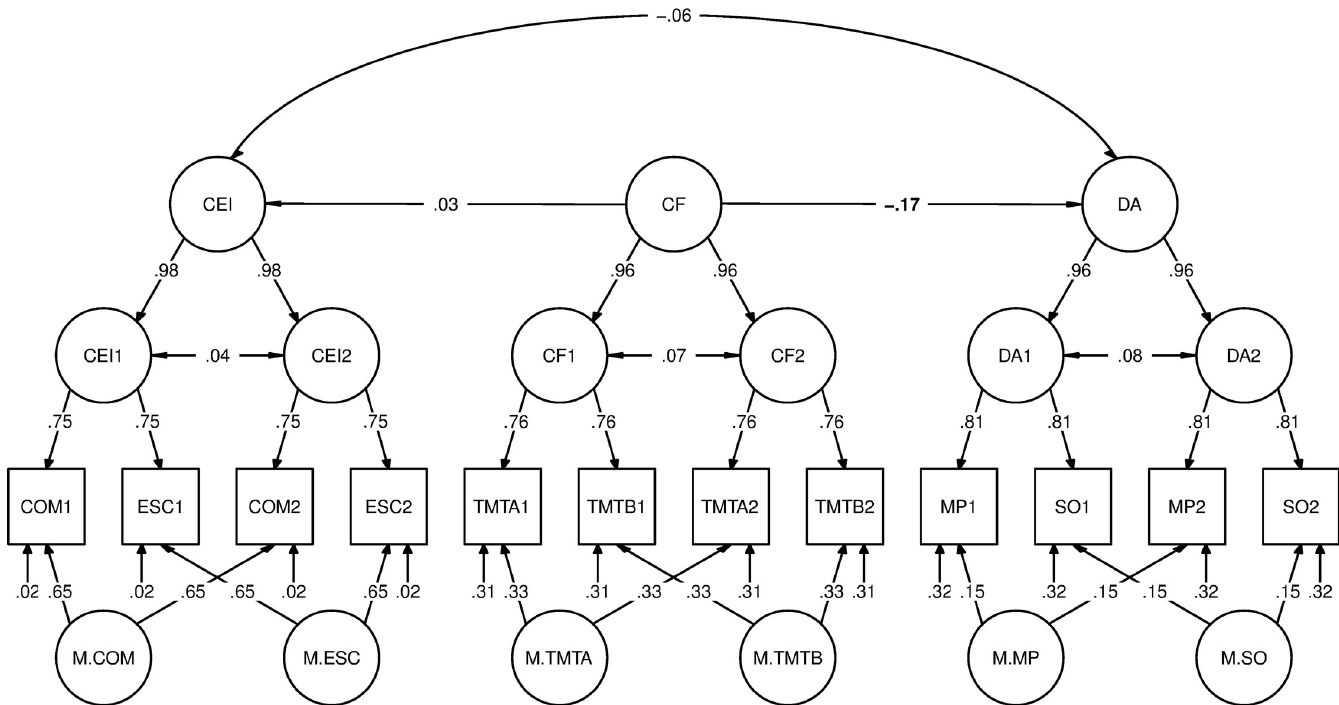
Fig 2. Latent state-trait model. Depicted is the relation between trait Cognitive Effort Investment (CEI) and Demand Avoidance (DA), controlled for Cognitive Functioning (CF) at the top as estimated from latent state CEI, DA and CF at the next-lower level (bold-faced: p < .05). Indicator variables in squares are COM = Cognitive Motivation and ESC = Effortful Self-Control factor scores, TMT = Trail-Making Test scores in versions A and B, MP = Demand Selection Task with Magnitude/Parity evaluation, SO = Demand Selection Task with Sound/Orthography evaluation, at the two measurement occasions 1 and 2; M = latent method factors at the bottom.